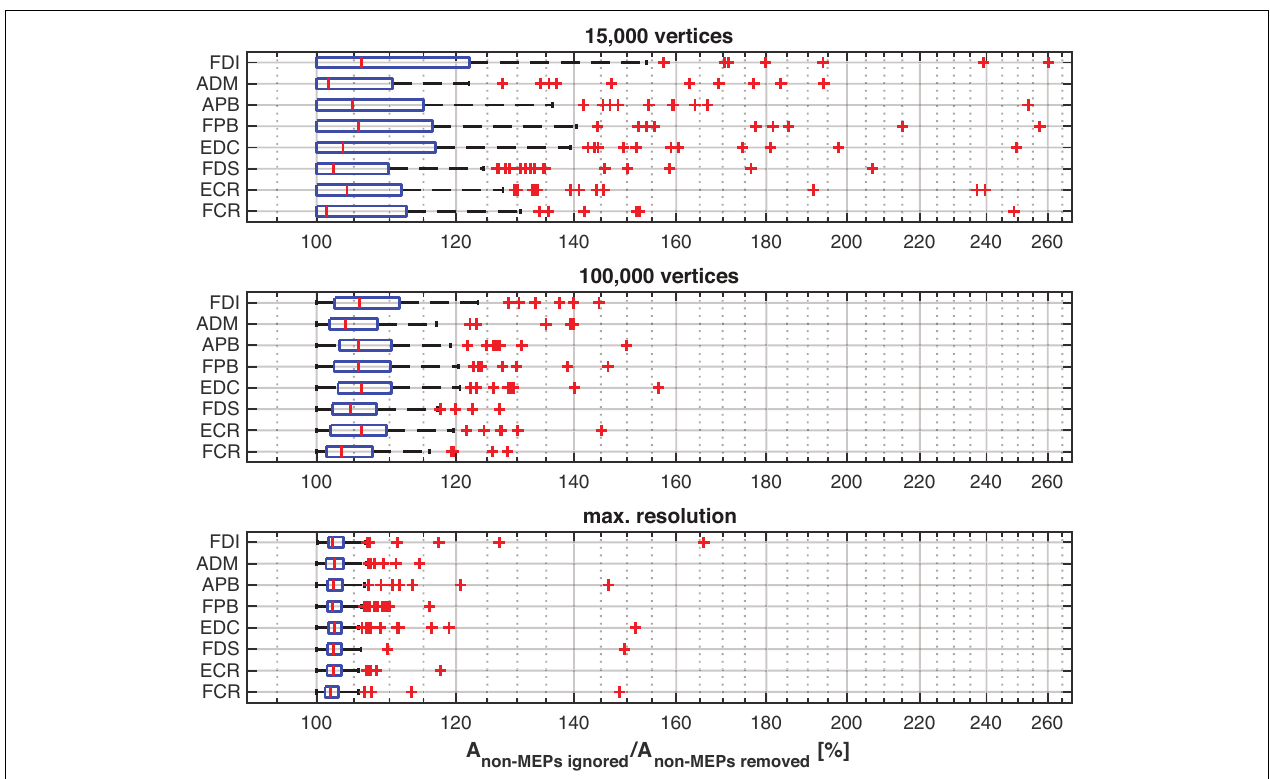
FIGURE 6 | The relative change of the size of the estimated active area per muscle using different resolutions of the cortex mesh. The maximum number of vertices was subject specific and ranged from about 230,000 to 340,000 vertices. The figure shows boxplots with red crosses marking outliers (all subjects/sessions entered the median and quantile estimates). Throughout mesh resolution the removal of non-MEP points yielded larger area sizes suggesting an overestimation of the active